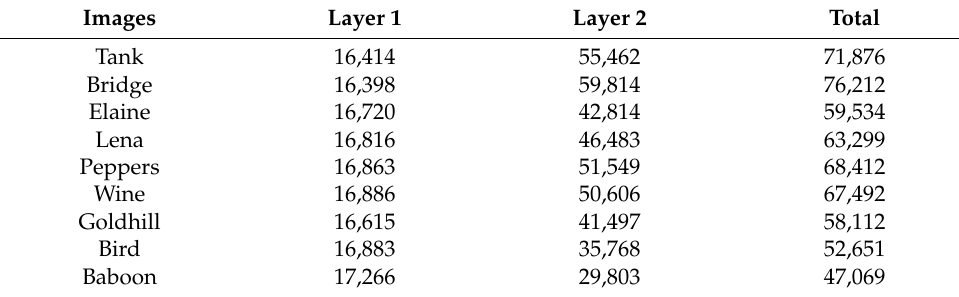
Table 4. Embedding capacity for different layers of the proposed scheme